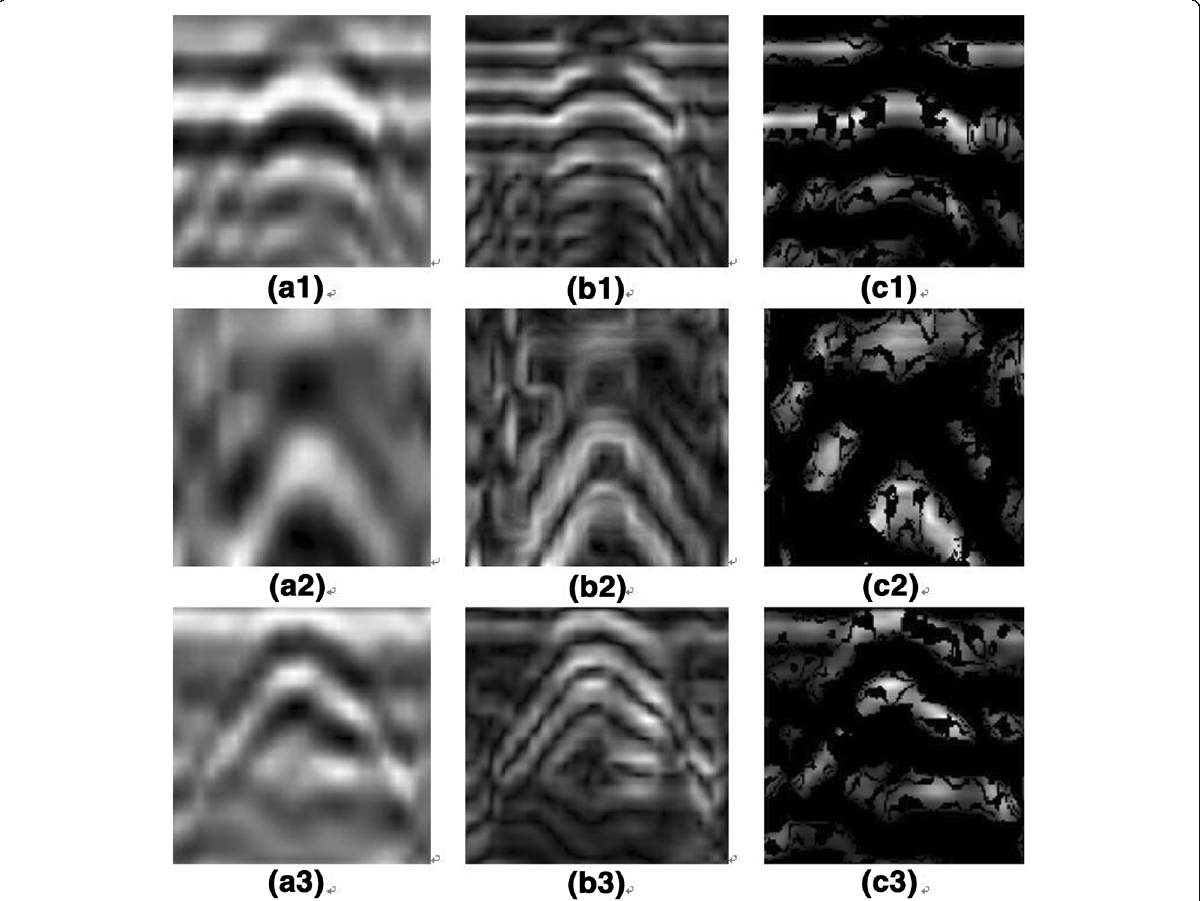
Fig. 2 Visual examples of feature descriptions using the Zernike moment. a Test images, b images with n = 7 and m = 1, and c the transformed